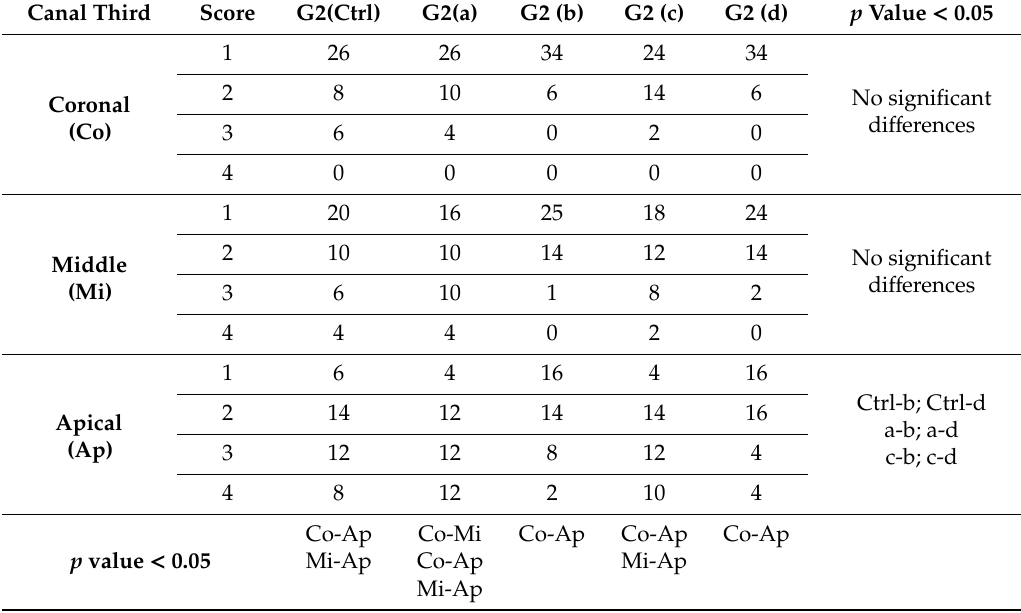
Table 2. Number of samples registered for each score of smear layer removal in the di ff erent root canal thirds for the di ff erent irrigation techniques of G2 (with pre-endodontic restoration). Abbreviations in the last column and last row indicate significant di ff erences between the di ff erent subgroups and / or thirds ( p < 0.05); Co: Coronal, Mi: Middle, Ap: Apical; Subgroups: ctrl,